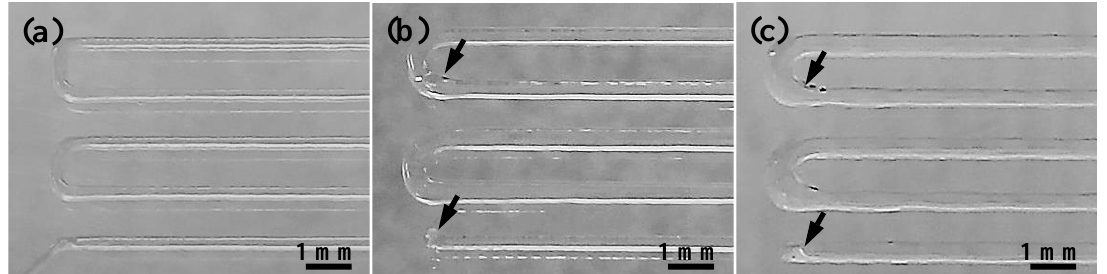
Figure 1. The combinations of 3BE-1 with different diameters of stainless steel needle heads were used to print a straight-line: ( a ) Ф 0.13 mm, ( b ) Ф 0.33 mm, and ( c ) Ф 0.9 mm.